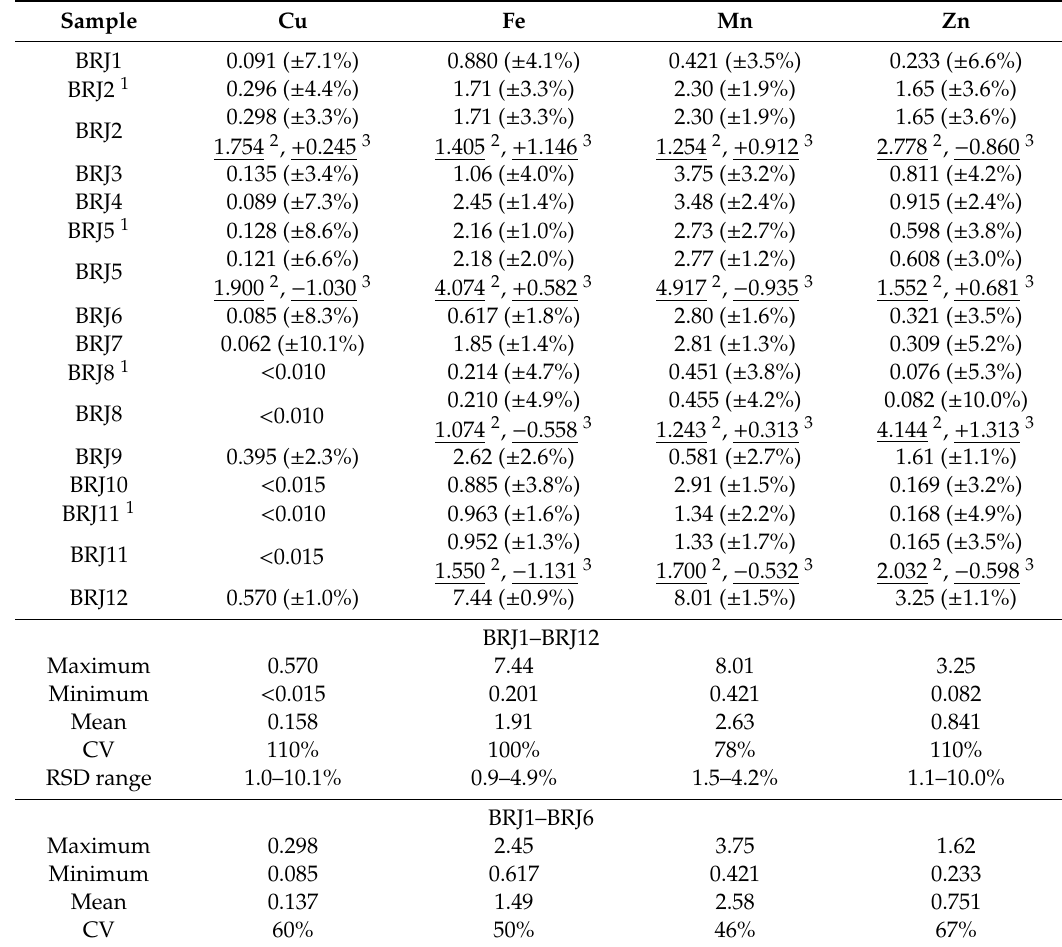
Table 2. The total concentrations (in mg L − 1 ) of Cu, Fe, Mn, and Zn in beetroot juices (BRJs) determined by flame atomic absorption spectrometry (FAAS) combined with the alternative sample preparation (the 2-fold dilution and the acidification with HNO 3 to 1 mol L − 1 ). For the selected beetroot juices (BRJ2, BRJ5, BRJ8, BRJ11), the concentrations of Cu, Fe, Mn, and Zn were also determined by the reference method RM1, i.e., the FAAS analysis of the sample solutions resulted from wet digestion with concentrated HNO 3 in the digestion